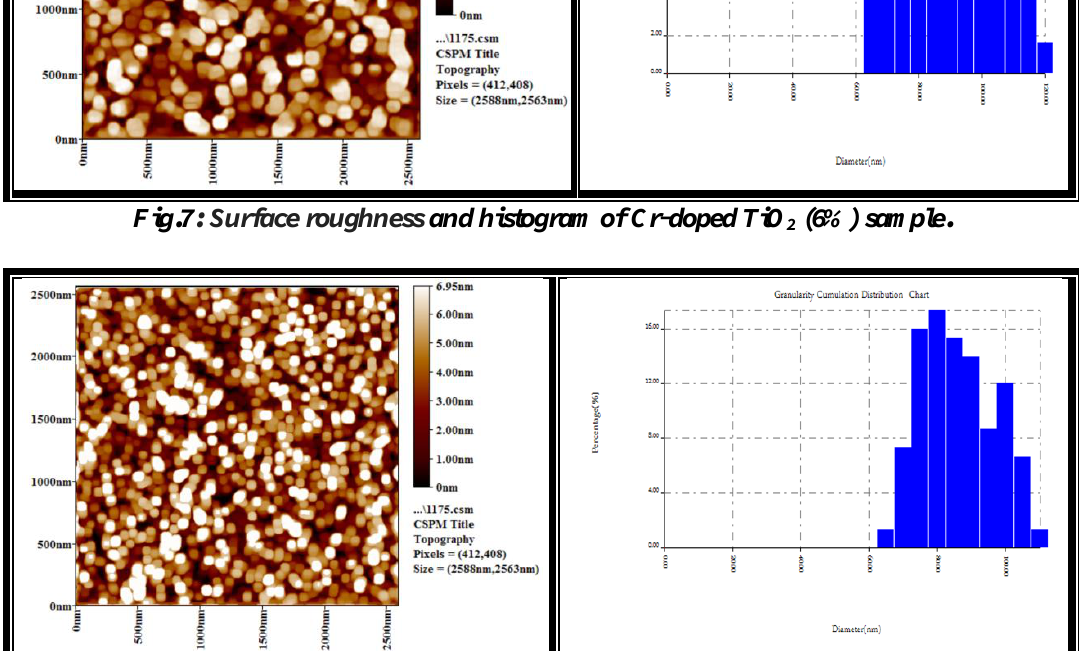
Fig.8: Surface roughness and histogram of Cr-doped TiO